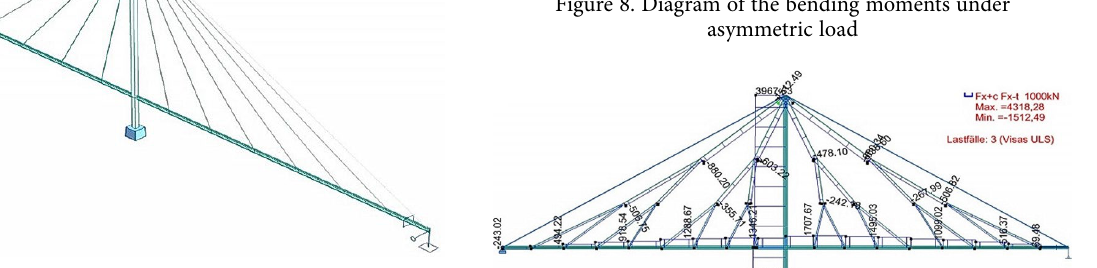
Figure 6. The structure scheme for the conventional cable-stayed bridge used for comparison with the new structure